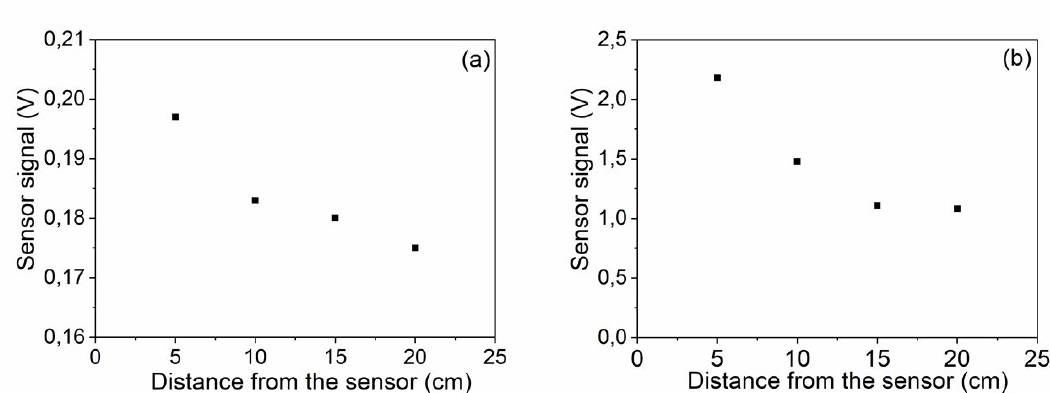
Figure 9. Sensor response to the massive ball drop for different distances from the AE source. (a) 1-3 PUR/PZT sample with 15 vol.% (45 rods) and (b) 34 vol.% (90 rods) of PZT.